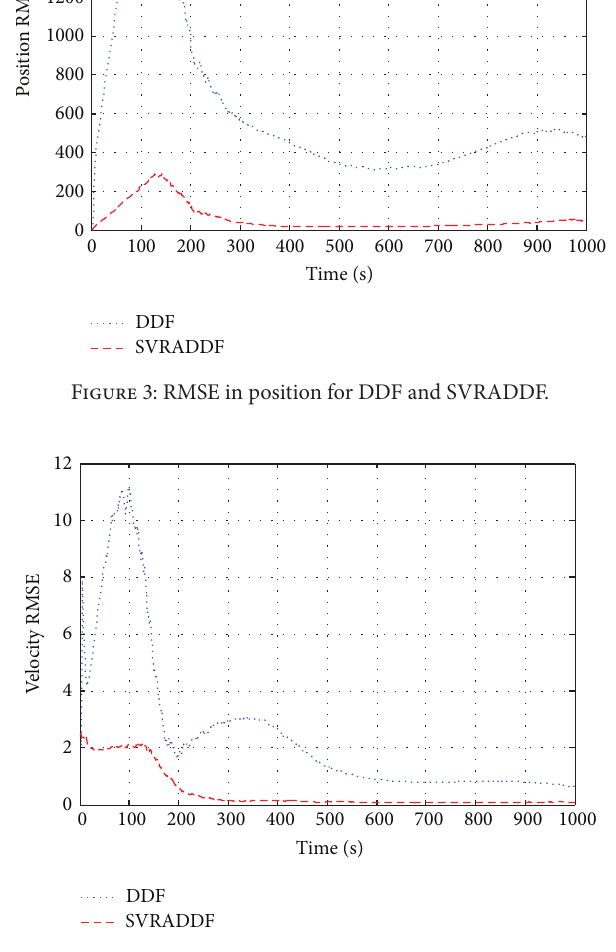
Figure 4: RMSE in velocity for DDF and